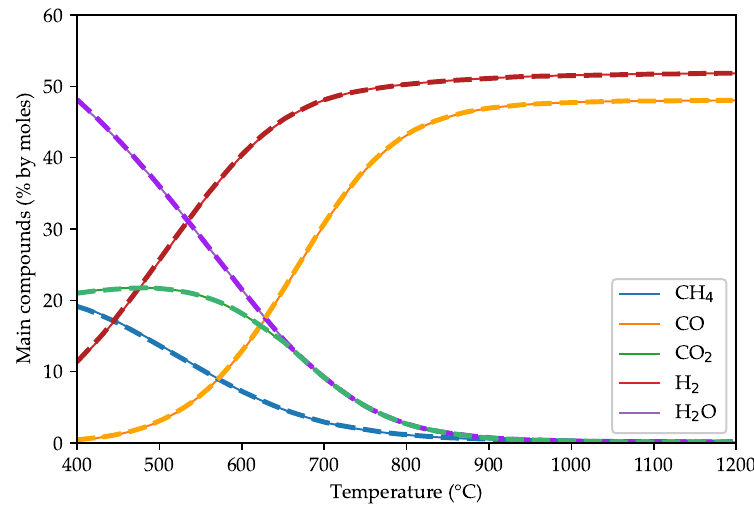
Figure 2. Simulation results for the synthesis gas equilibrium composition plotted as function of process temperature for the pine sawdust pyrolysis test at 0.1 MPa (dashed lines) compared to literature data [16] (solid